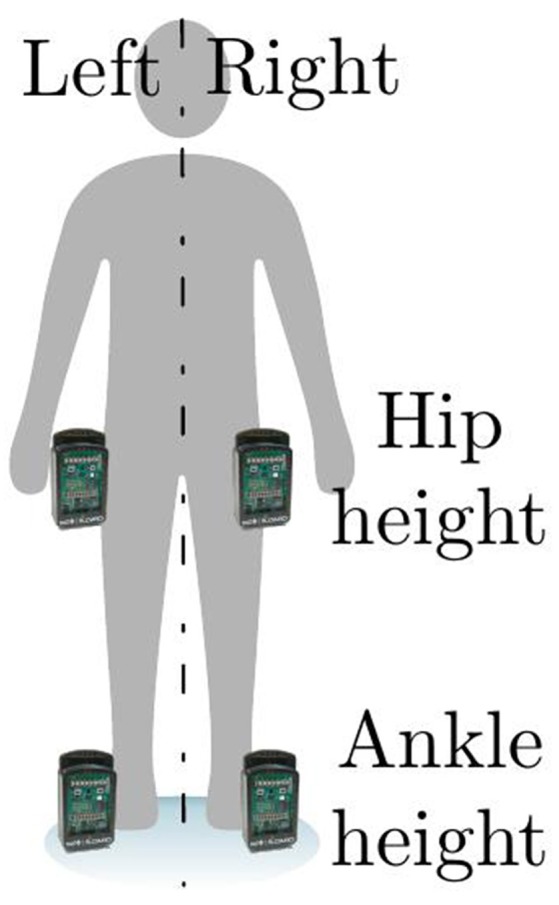
Localization of the measurement devices and spatial axes orientation.